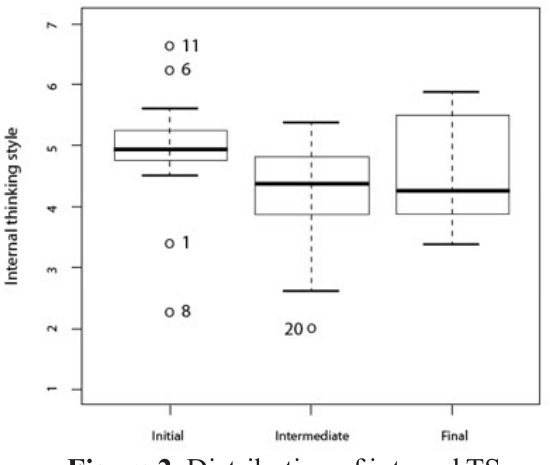
Figure 2. Distribution of internal TS,